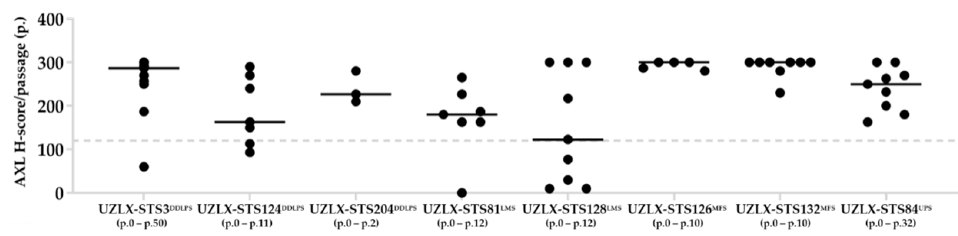
Figure 1. AXL H-scores of individual passages (p.) and included p. ranges for selected models.